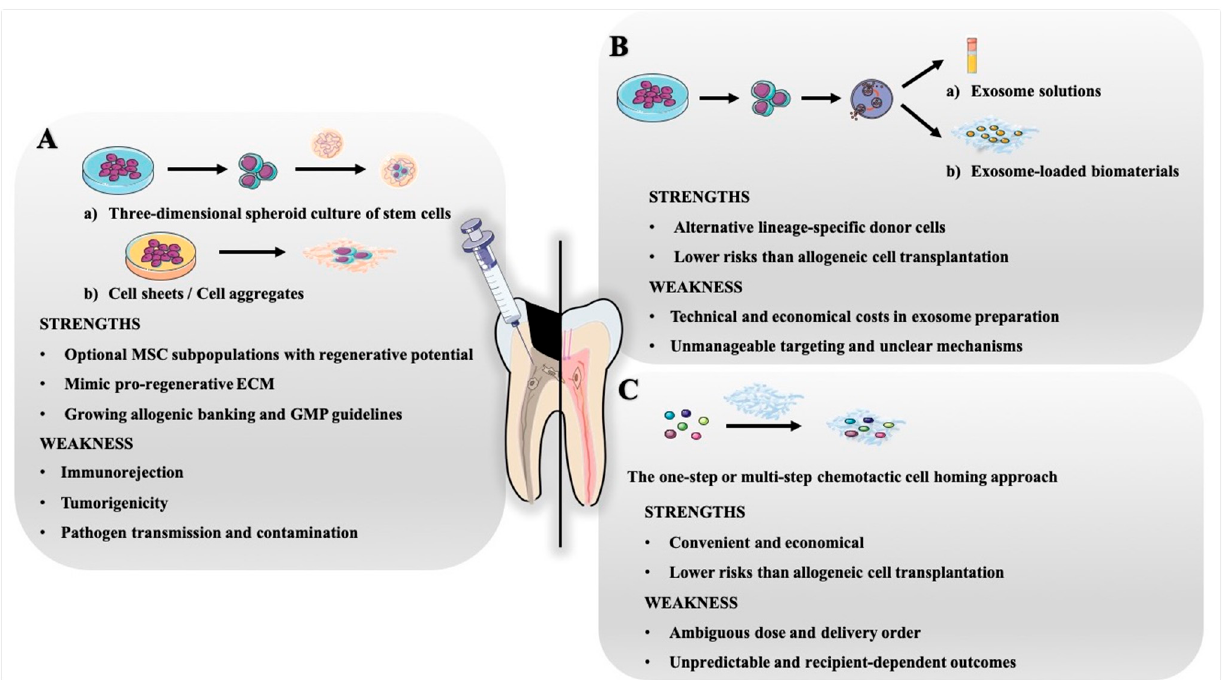
Figure 4. Comparison of three optimised strategies for pulp regeneration. ( A ) Novel culture methods for transplanted dental stem cells, such as three-dimensional spheroid culture systems, cell sheets, and cell aggregates, are beneficial for determining the optimal regenerative subpopulations and mimic pro-regenerative ECM, while some limitations of allogeneic transplantation cannot be avoided. ( B ) Exosomes used for pulp regeneration could be selected from alternative lineage-specific donor cells; however, high costs in isolation, identification, and administration before application may limit their large-scale production. Further investigations must focus on precise targeting and uptake testing. ( C ) An exogenous growth factor-mediated cell homing approach would be an operable and economical choice for pulp regeneration, although a wide variation in growth factor types, applied dosages, and delivery orders among recipients may lead to unpredictable outcomes.